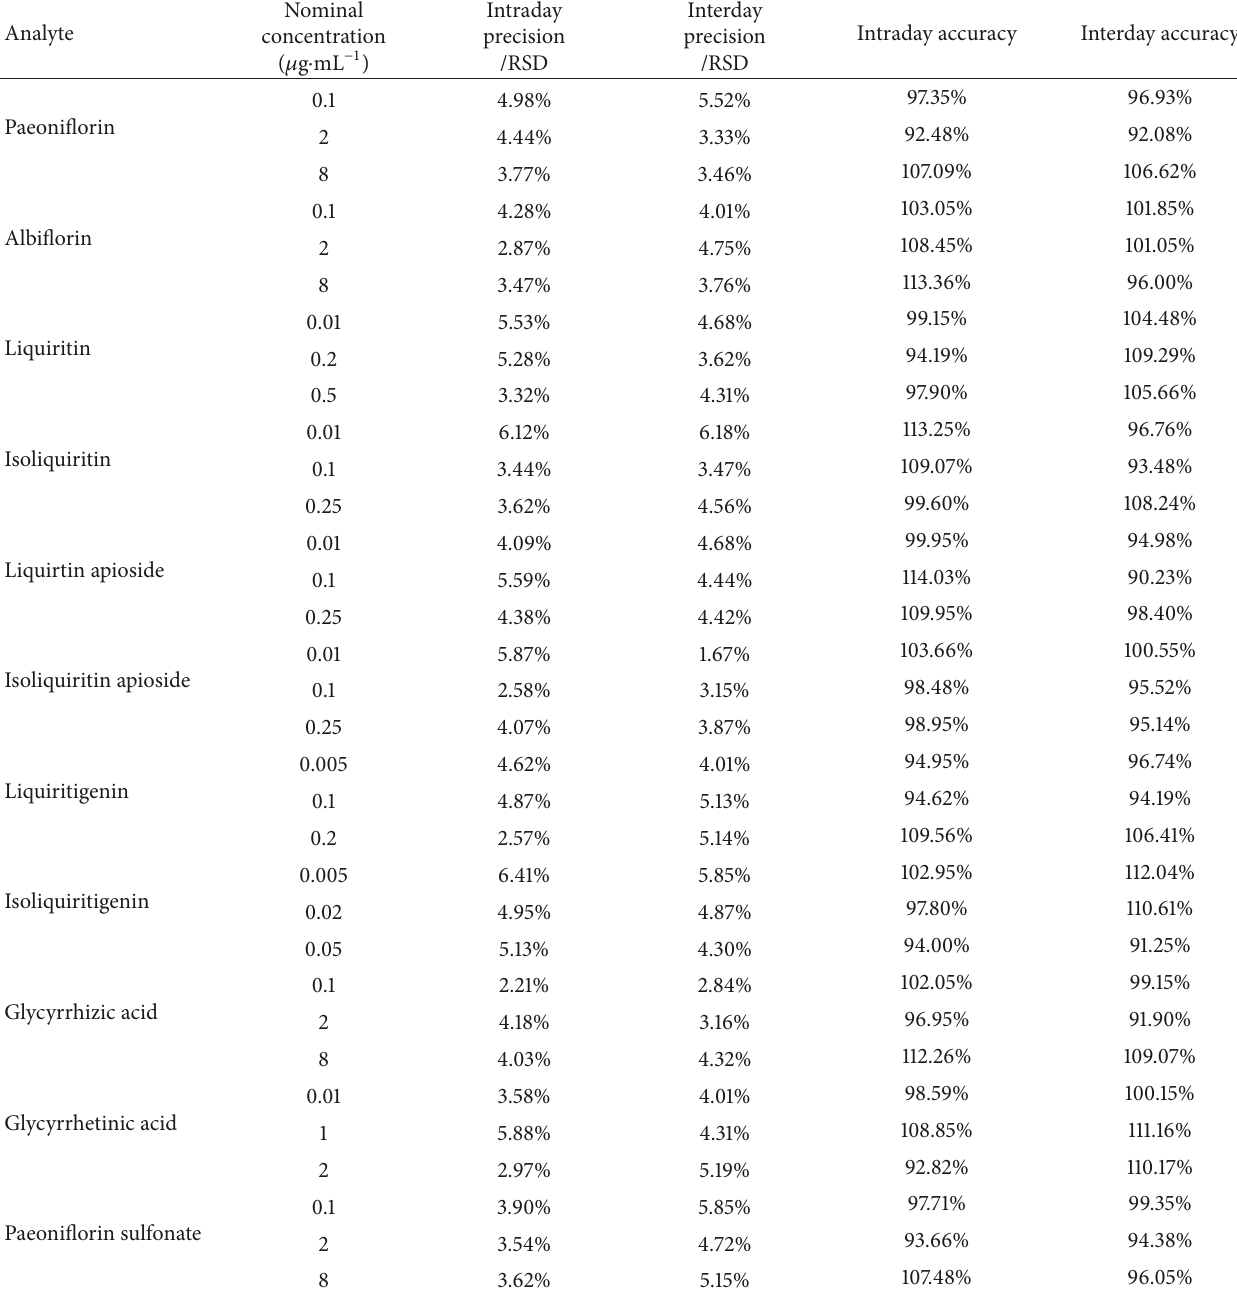
Table 4: The precision and accuracy of detected compounds in rat plasma ( 𝑛 = 6